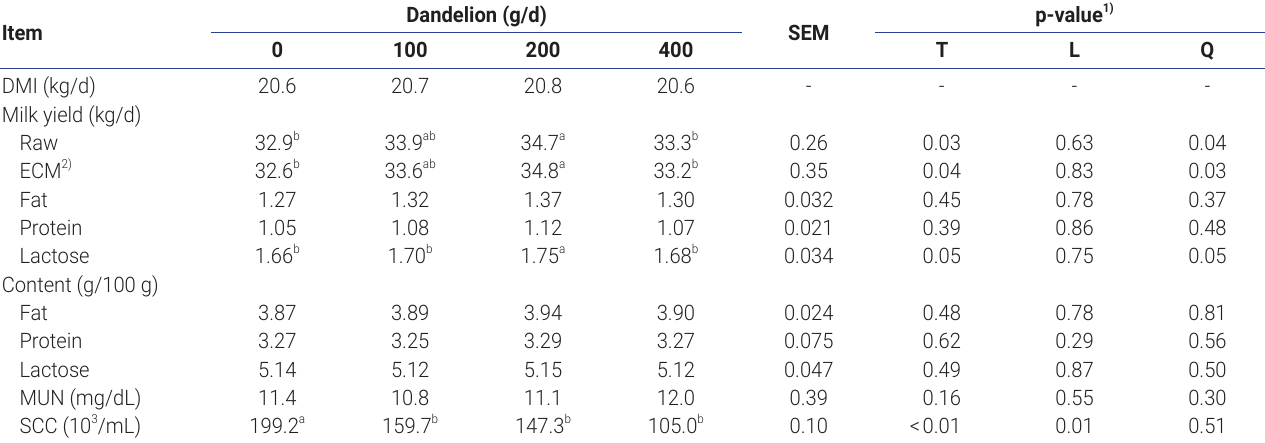
Table 1. Effects of dietary dandelion supplements on feed intake and lactation performance in primiparous dairy